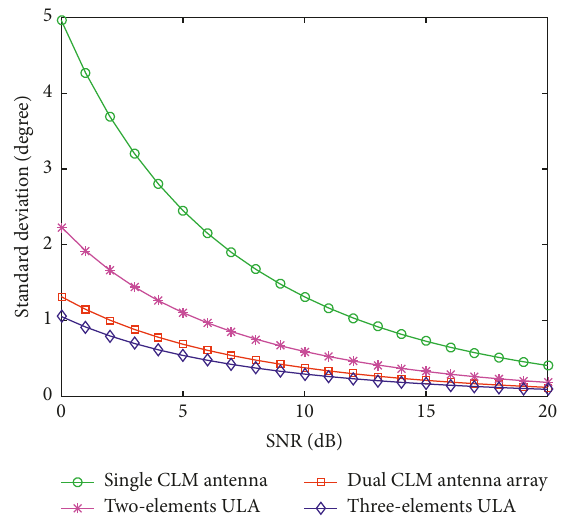
Figure 2: Theoretical MUSIC error of different antenna types. For the dual CLM array and ULAs, the array spacing is set as half- wavelength.